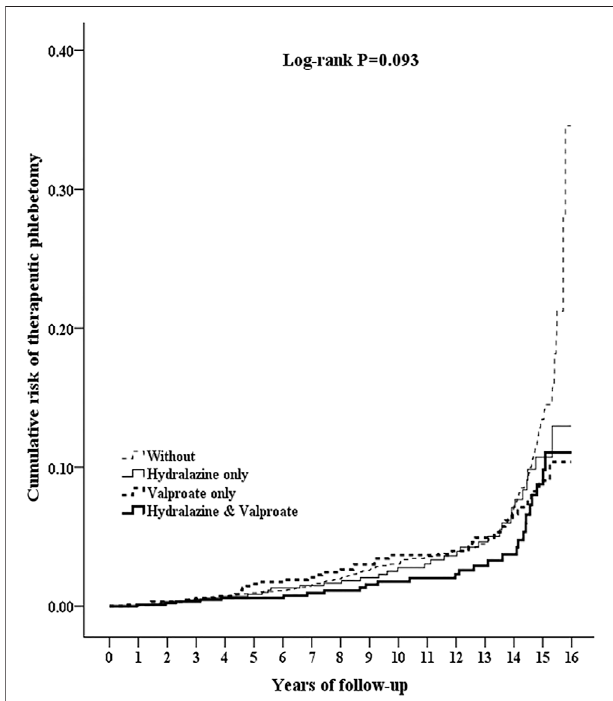
FIGURE 2 | Kaplan – Meier curves for cumulative risk of requiring therapeutic phlebotomy in patients aged ≥ 20 from different cohorts drawn using the log-rank test. Log-rank test: Control vs. hydralazine, p = 0.058; control vs. valproate, p = 0.185; control vs. combination hydralazine – valproate, p = 0.018; hydralazine vs. valproate, p = 0.971; hydralazine vs. combination hydralazine – valproate, p = 0.258; valproate vs. combination hydralazine – valproate, p = 0.318.